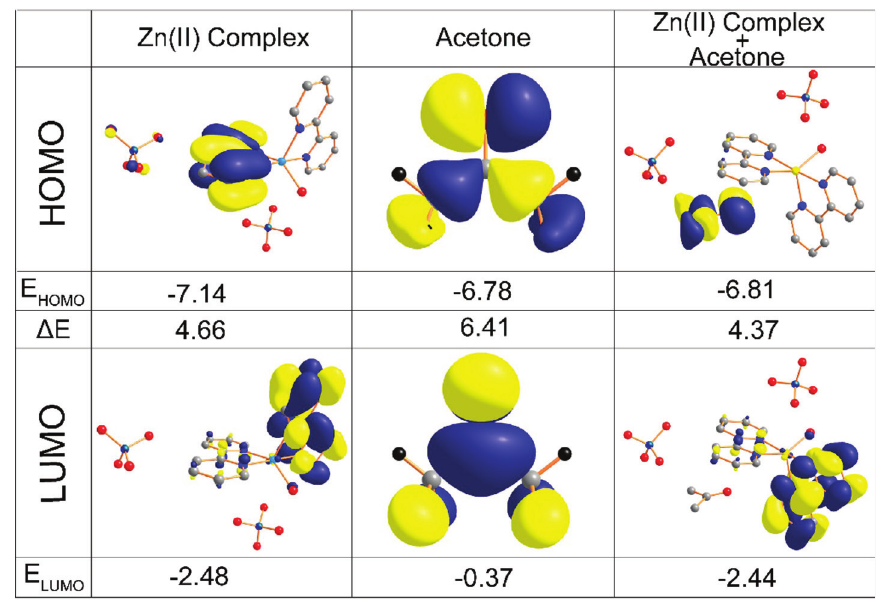
Figure 8. Comparative frontier molecular orbital diagram.